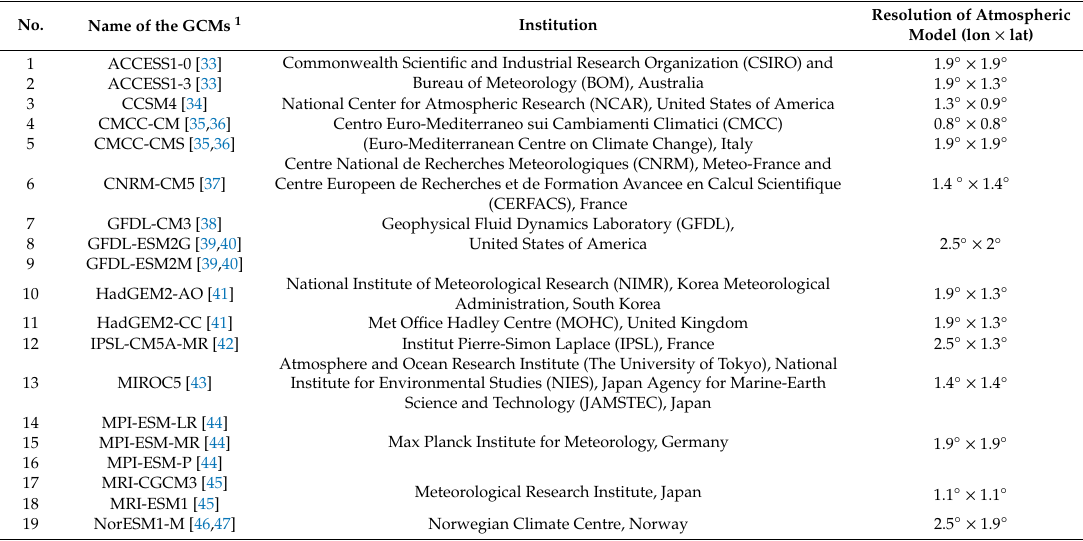
Table 1. List of the selected general circulation models (GCMs) used in the